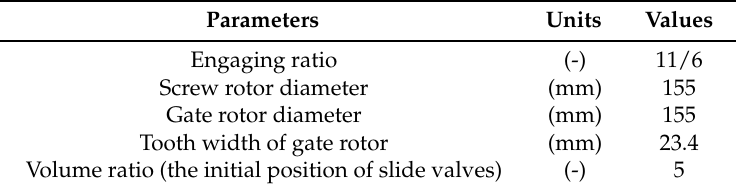
Table 2. Main parameters of SSE.